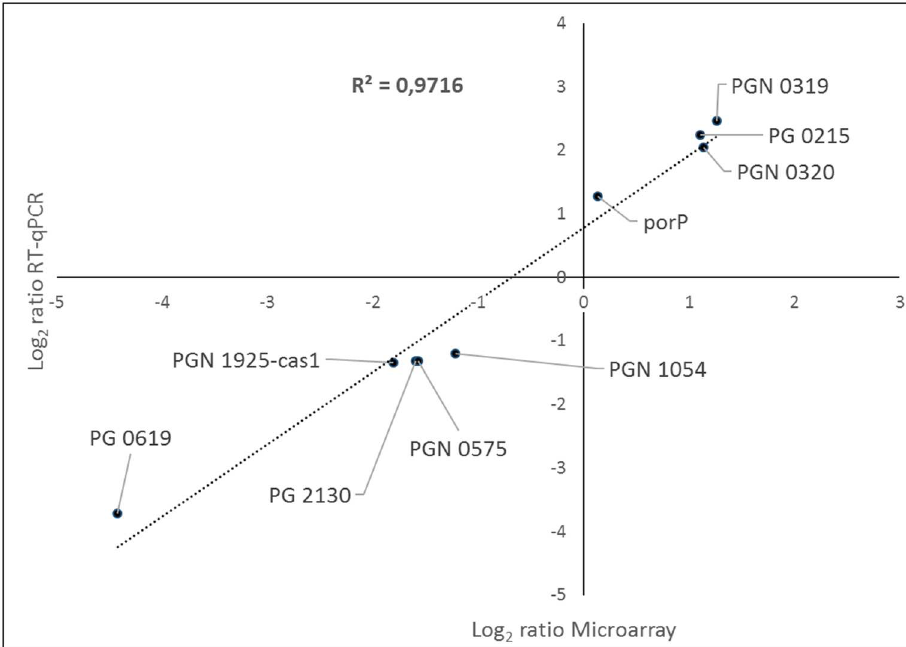
Fig 3. Correlation between microarrayand ReverseTranscription-quantitative Polymerase Chain Reaction (RT-qPCR) gene expression ratios determined for biofilm versus planktonic cells. The RT- qPCR log 2 values were plotted againstthe microarraydata log 2 values (R 2 =